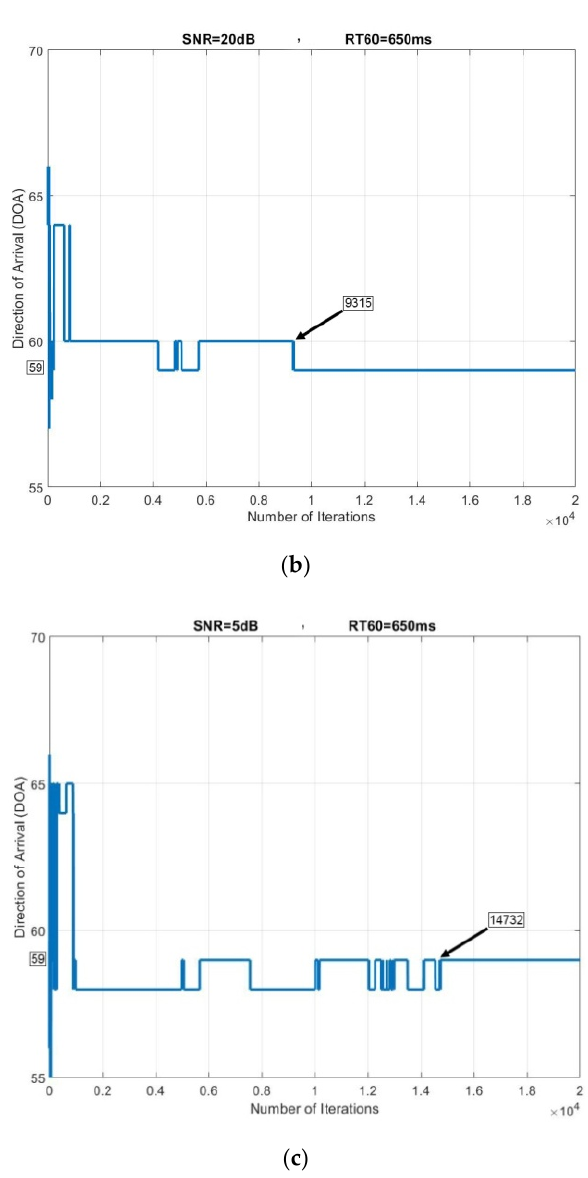
Figure 10. The convergence curve for subband GEVD (SBGEVD) algorithm for the first speaker in subband 1.8–2 kHz, ( a ) noisy, ( b ) reverberant, and ( c ) noisy-reverberant scenarios.